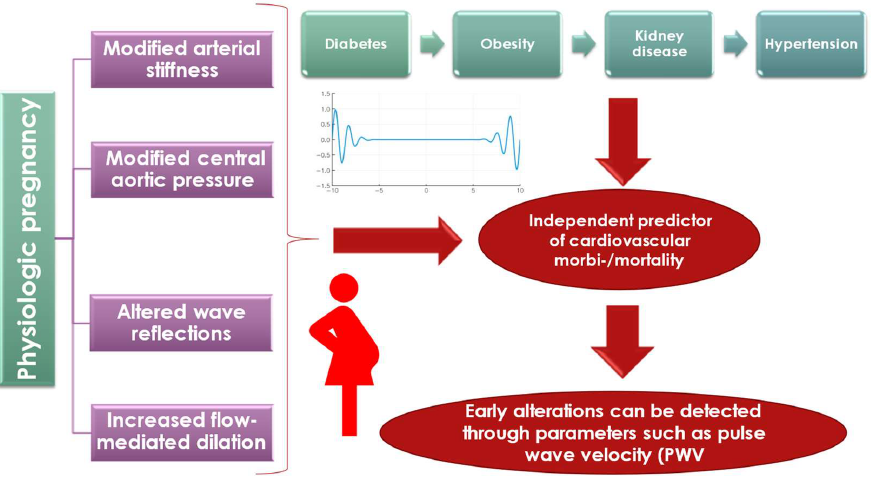
Figure 5. The interconnections between physiological vascular modifications, arterial stiffness and risk factors/pathologies (diabetes, obesity, kidney disease, hypertension).